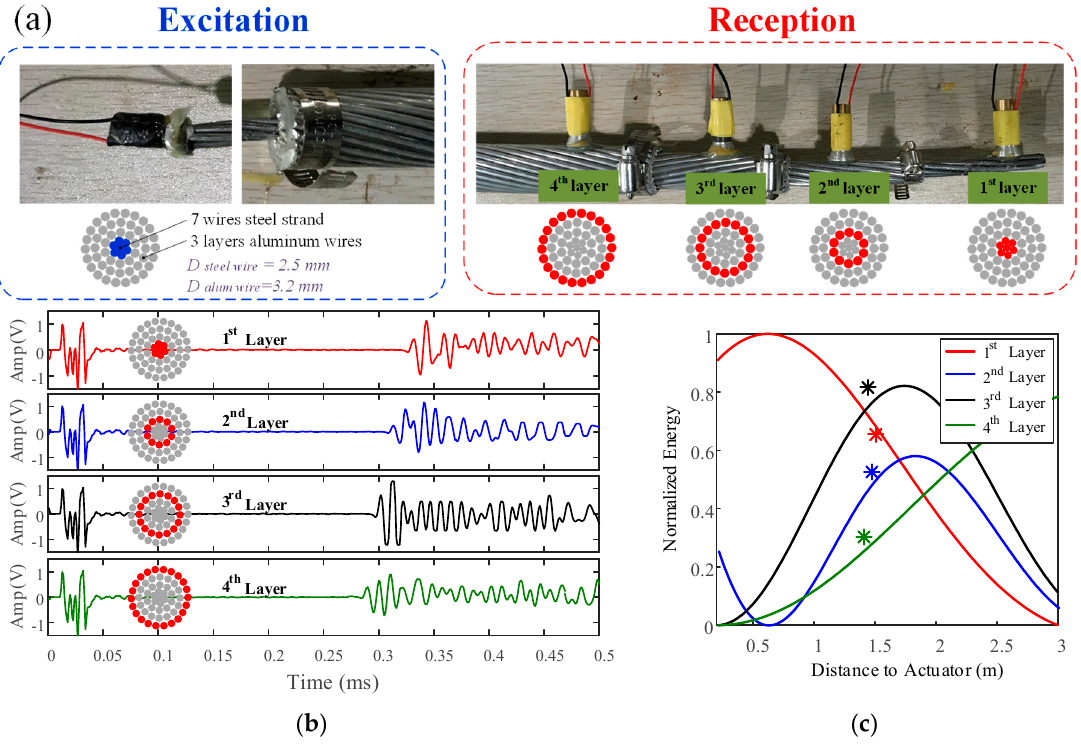
Figure 14. Guided wave propagation experiments on the aluminum conductor steel-reinforced (ACSR) cable: ( a ) a photo of the exciting and receiving transducers installation, ( b ) the received time domain signals of each layer, and ( c ) the simulated and measured time average wave energy distribution in each layer.